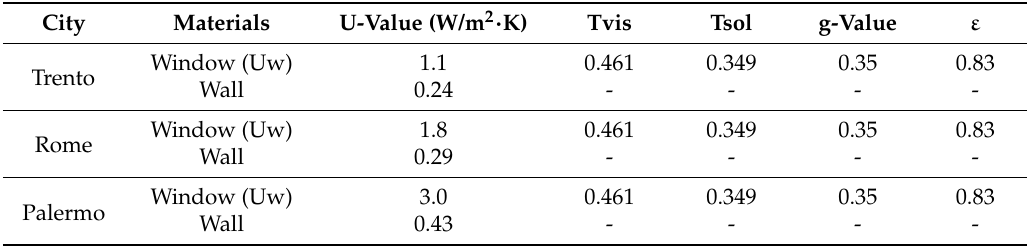
Table 5. Thermal and optical properties of the double glazing element and walls (NZEB).